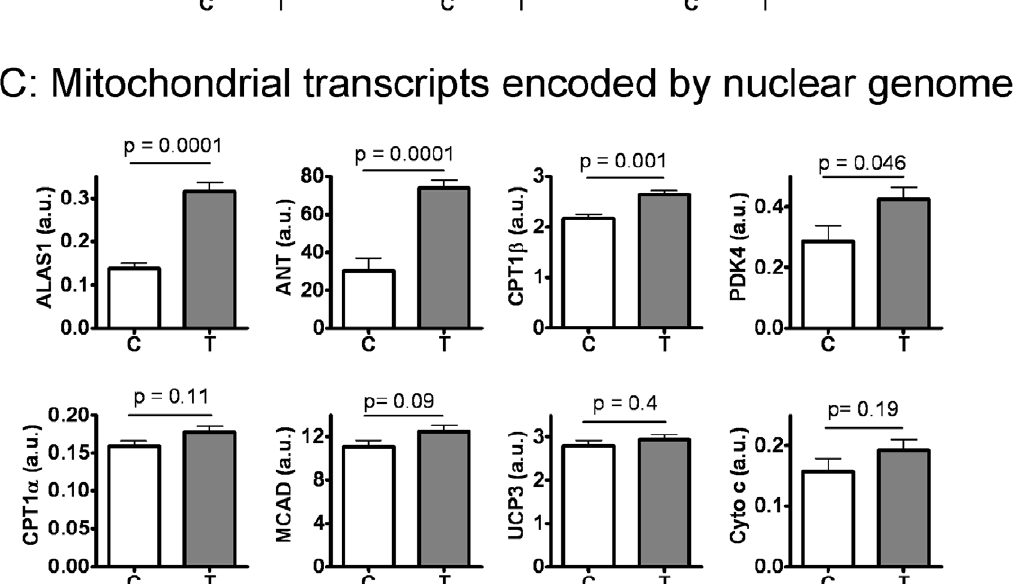
Figure 2. Effect of testosterone supplementation plus low-intensity physical training on markers of mitochondrial biogenesis in the skeletal muscle. ( A ) Testosterone increased mitochondrial DNA (mtDNA) copy number when normalized to nuclear genome DNA (nDNA). ( B ) Testosterone increased mtDNA-encoded mitochondrial transcripts for markers of complex I (NADH dehydrogenase subunits: ND1, ND4), complex III (cytochrome b: Cyto b), complex IV (cytochrome c oxidase subunits: Cox2a and Cox3a), and complex V (ATP synthase subunit 6, APT6) of the electron transport chain. ( C ) Testosterone increased the expression of selected nuclear genome-encoded mitochondrial transcripts for d -aminolevulinate synthase 1 (ALAS1), adenine nucleotide translocator (ANT), Carnitine palmitoyltransferase 1(CPT1 b , CPT1 a ). pyruvate dehydrogenase kinase 4 (PDK4), medium-chain acylCoA dehydrogenase (MCAD), uncoupling protein 3 (UCP3), and cytochrom c (Cyto c). All qPCR results were normalized to house- keeping gene Hypoxanthine phosphoribosyltransferase (HPRT) and expressed in an arbitrary unit (a.u). All results were obtained from triceps and presented as mean 6 SEM and compared by t test. N=5 for the control (C) and N=8 for the testosterone (T) group.